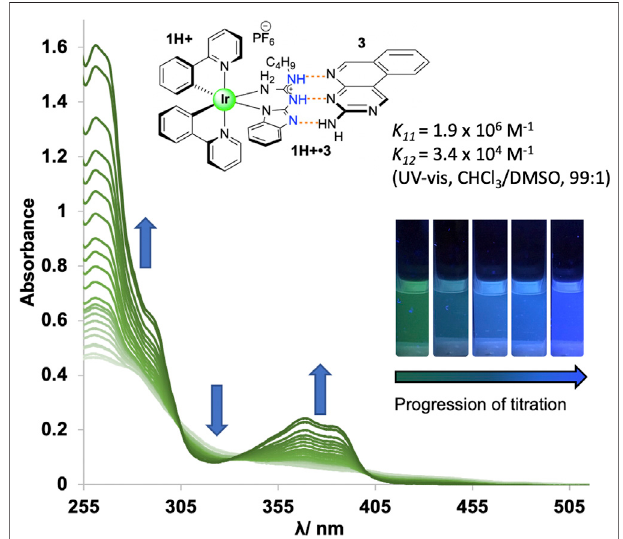
FIGURE 2 | UV-vis absorbance spectra from a titration experiment (cid:129) 3 in CHCl 3 /DMSO (99:1 v/v). (298 K) for co-system 1H +